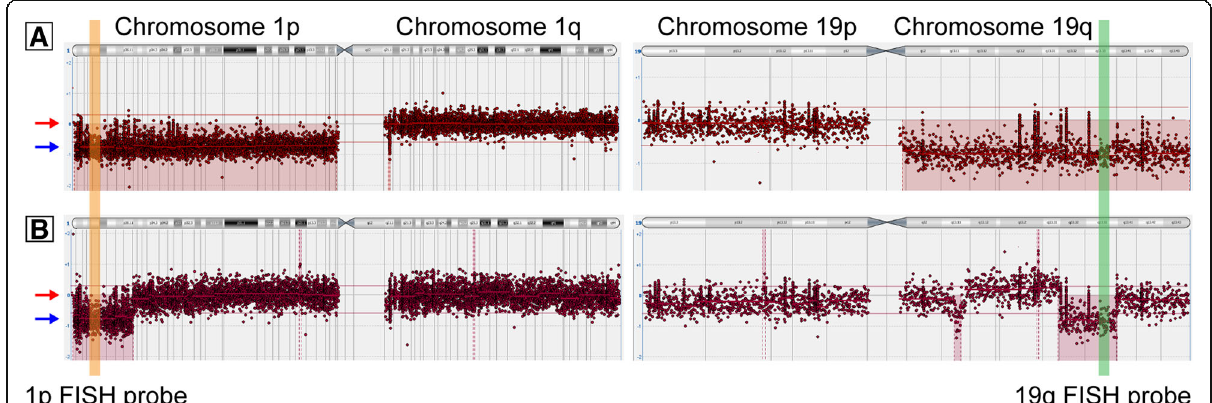
Fig. 3 Assessment for whole-arm 1p and 19q loss. Examples of single nucleotide polymorphism chromosomal arrays (SNP microarrays) for ( a ) IDH-mutant oligodendroglioma and ( b ) IDH-wildtype glioblastoma. Red arrows mark a neutral copy number, and blue arrows accompanied by red shading indicate areas of copy number loss. Note that in oligodendroglioma, the entire 1p and 19q arms show copy number loss. In contrast, for the glioblastoma, there is only focal loss of distal 1p, and a focal interstitial loss on 19q, with these areas encompassing the region that corresponds to FISH probes for 1p (orange shading) and 19q (green shading). The probe annealing regions are not to